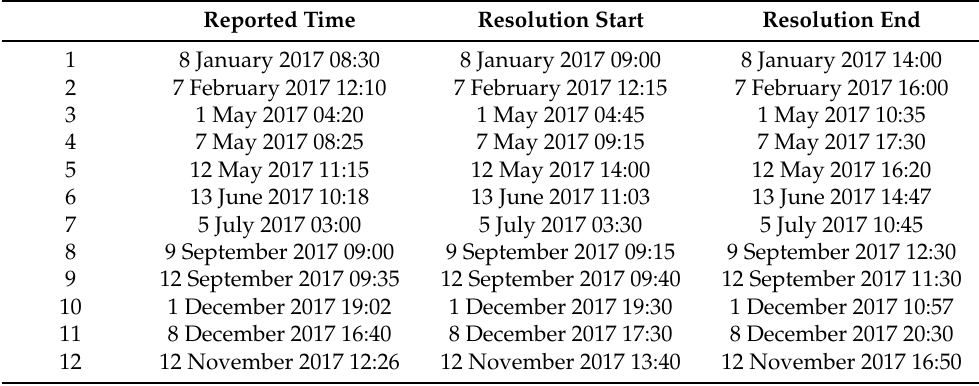
Table 4. Reported leakages in